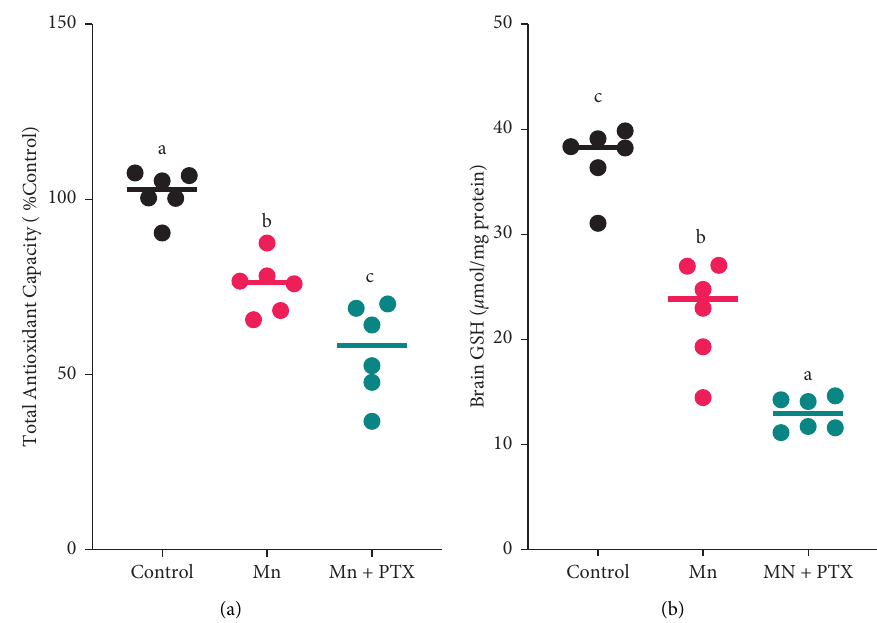
Figure 3: Evaluating the effect of PTX on (a) the total antioxidant capacity (TAC) and (b) glutathione (GSH) content in the brain tissue. Data are represented as mean ± SD. According to the post hoc Tukey test, groups with the same superscripted letters were not significantly different at α � 0.05 ( P ≥ 0 . 05 ) . However, dissimilar letters indicate a significant difference ( P < 0 . 05 ) .